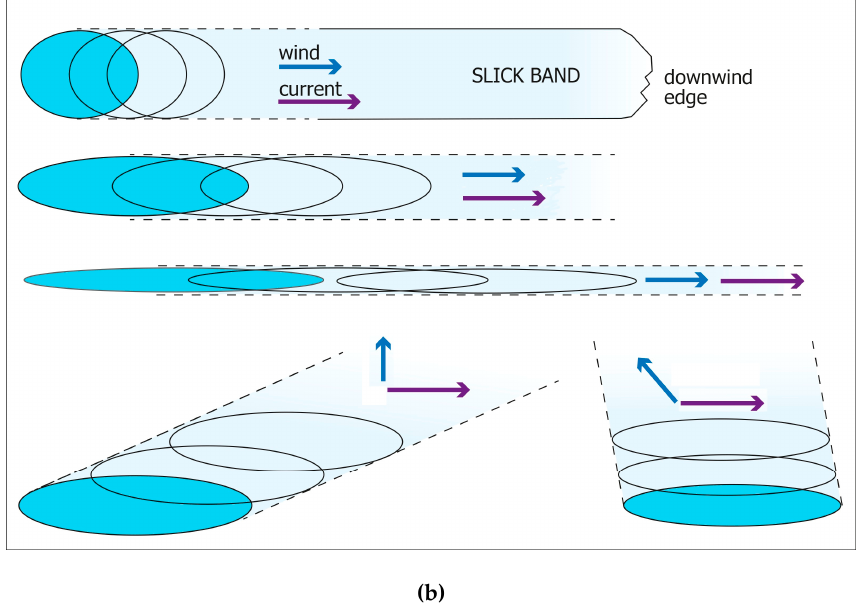
Figure 1. ( a ) A map of the study area. ( b ) Schematic representation of an artificial slick band formation at various speeds and directions of the near-surface wind and current.